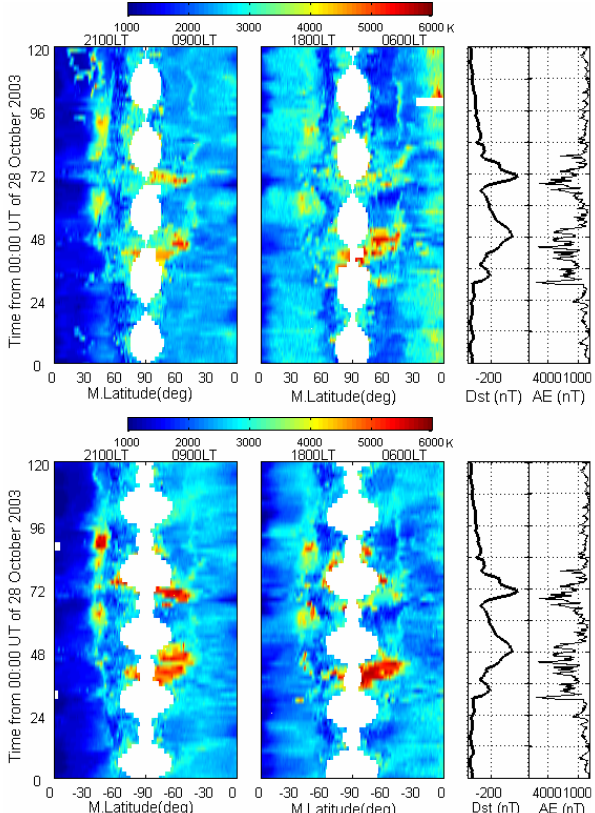
Fig. 5. The variation of ion temperature Ti(maglat, UT) in the northern (upper panel) and southern hemispheres (bottom panel) at 2100 LT, 0900 LT, 1800 LT and 0600 LT measured by DMSP F13 and F15 at altitude 840km. The Dst and AE indices are shown at right columns as an indicator of the storm phase.